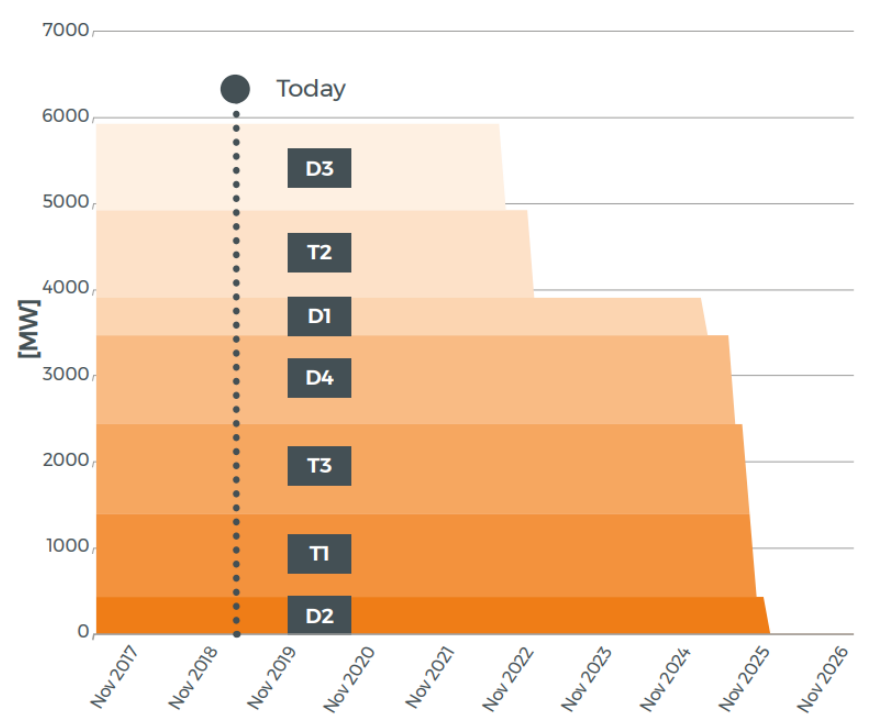
Figure 16. Phase out plan of nuclear plants in Belgium